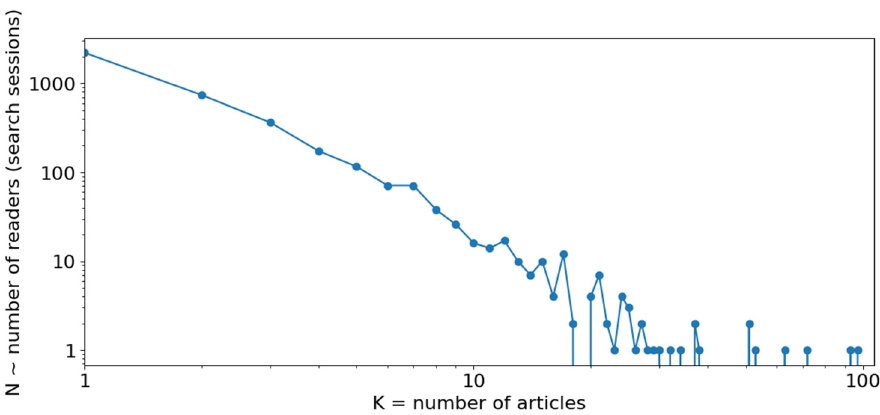
Figure 3. N and K values for one block of user sessions: quite a few people read more than ten articles while most readers read only one or two articles.